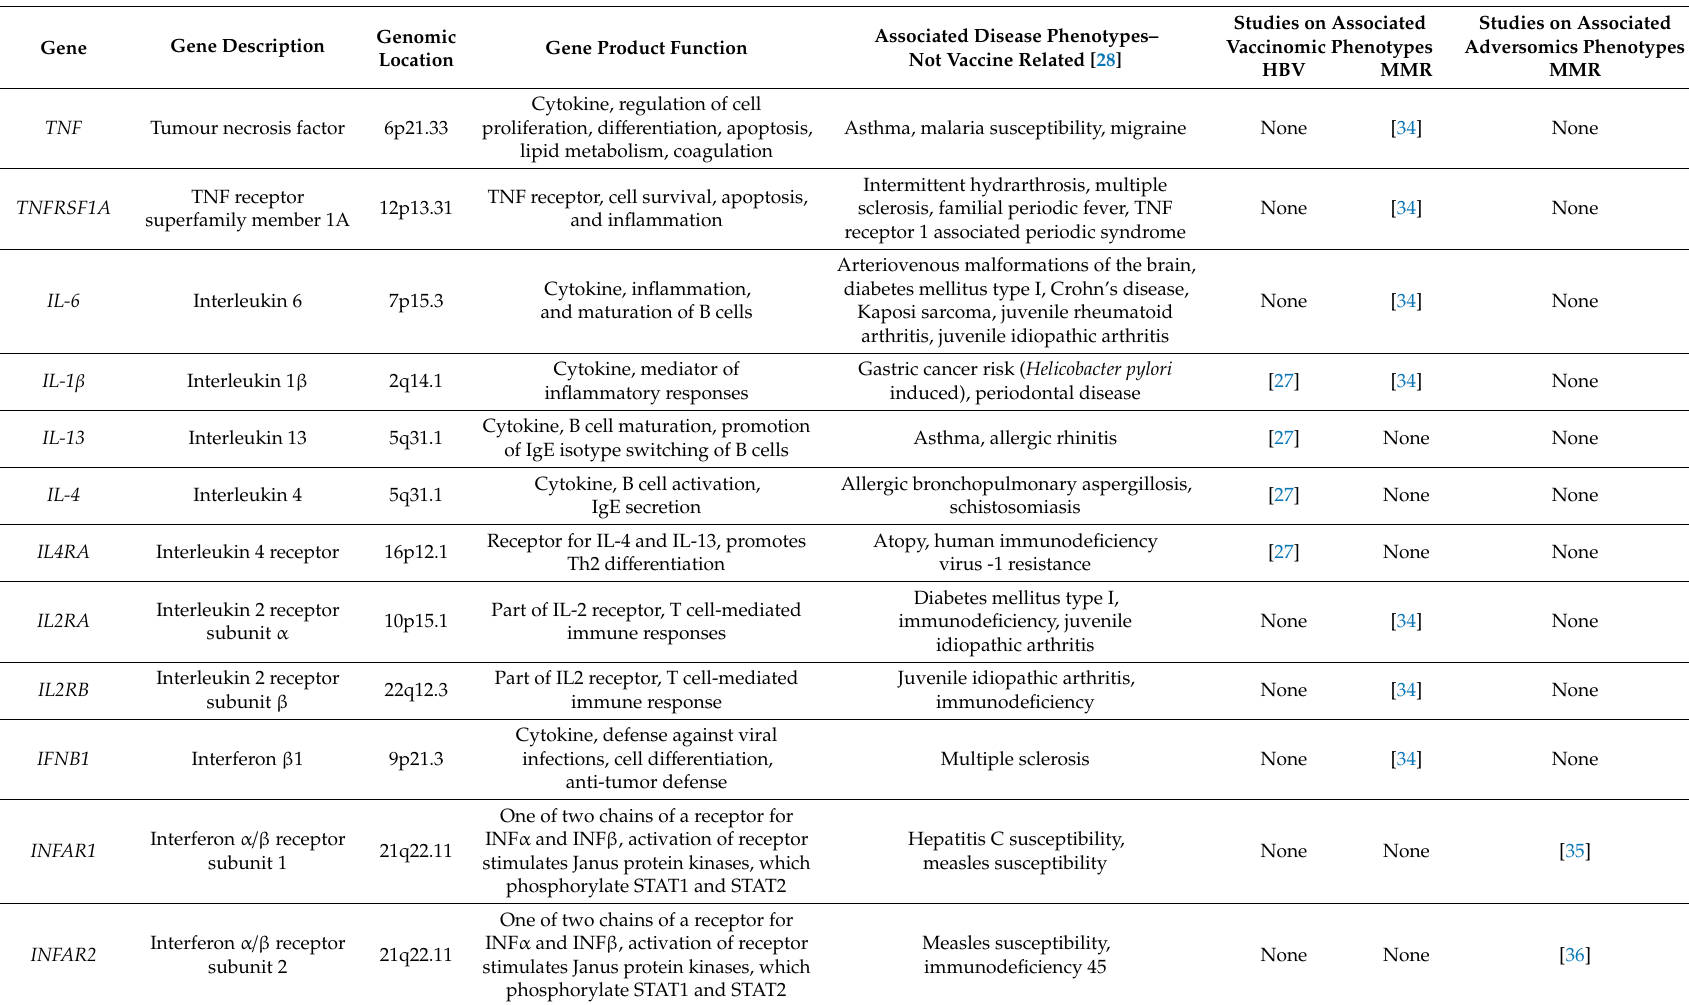
Table 2. Details of genes encoding cytokines and their receptors associated with HBV and MMR vaccine e ffi cacies and